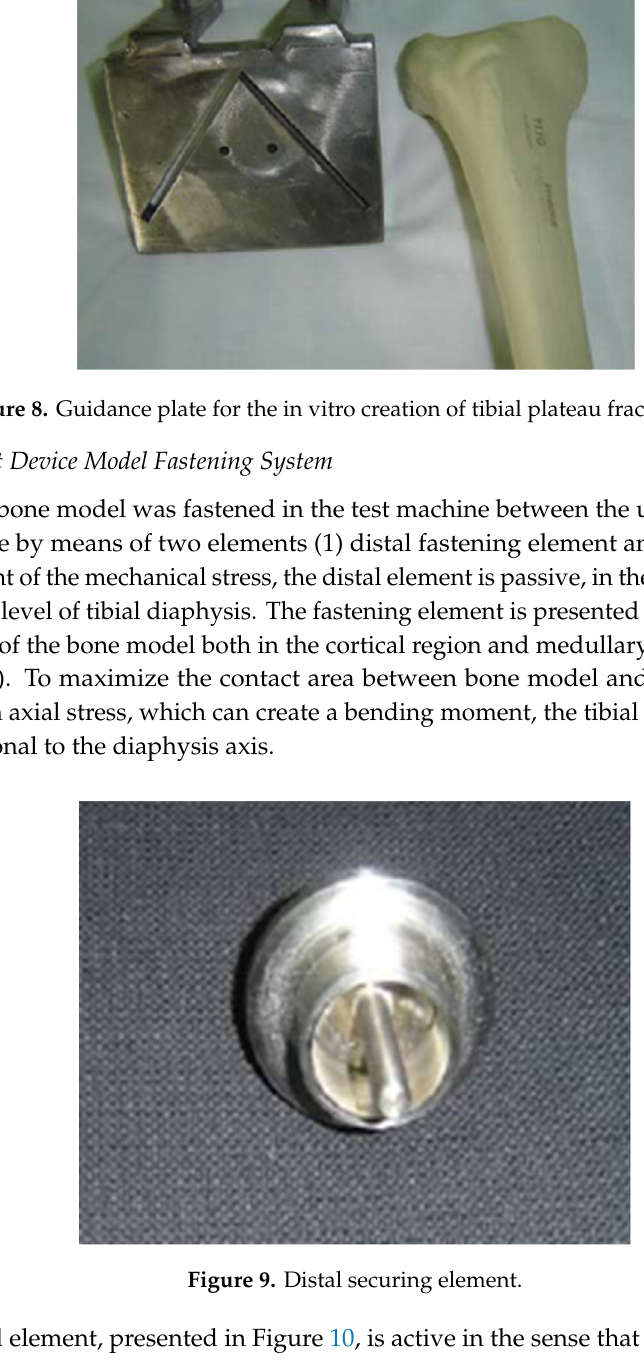
Figure 9. Distal securing element.